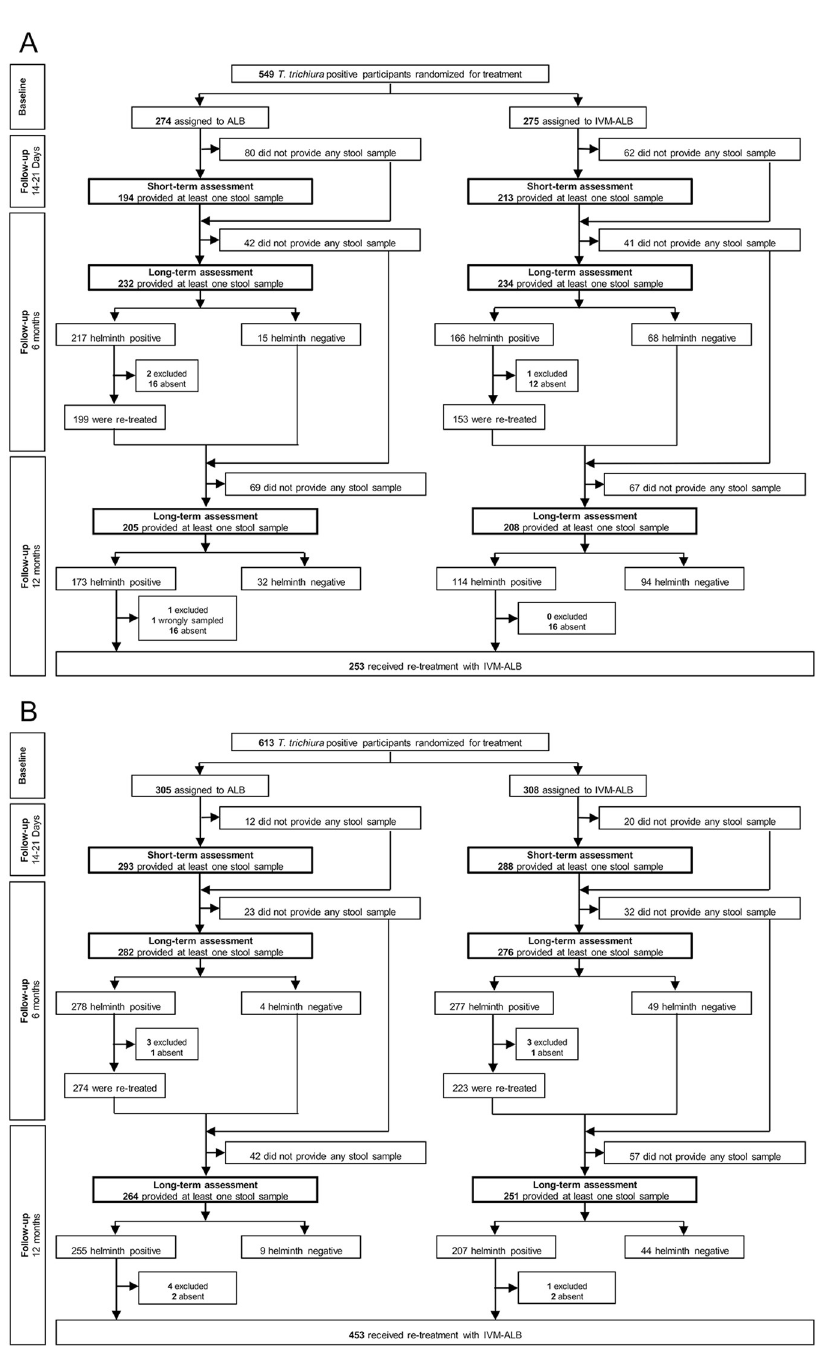
Fig 1. Study design flow chart for Lao PDR (A) and Pemba Island (B). Abbreviations: T . trichiura , Trichuris trichiura ; ALB, albendazole monotherapy; IVM-ALB, ivermectin-albendazole combination therapy. In Lao PDR “helminth positive” includes infections with Strongyloides stercoralis